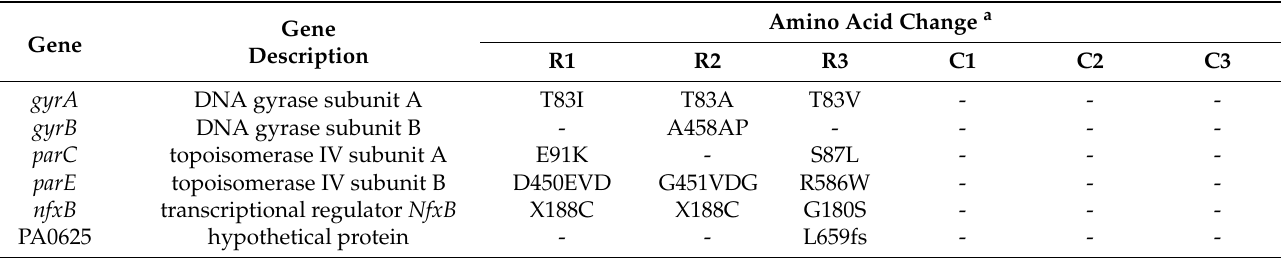
Table 2. Candidate mutations related to ciprofloxacin resistance in experimentally evolved strains by comparison with the P. aeruginosa